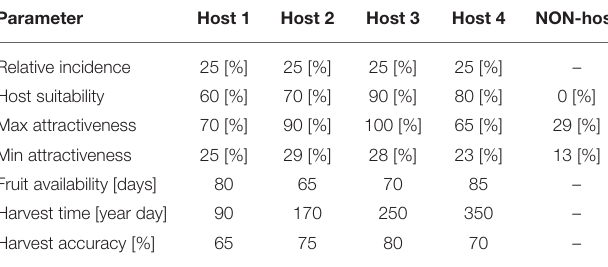
TABLE 3 | Host and non-host